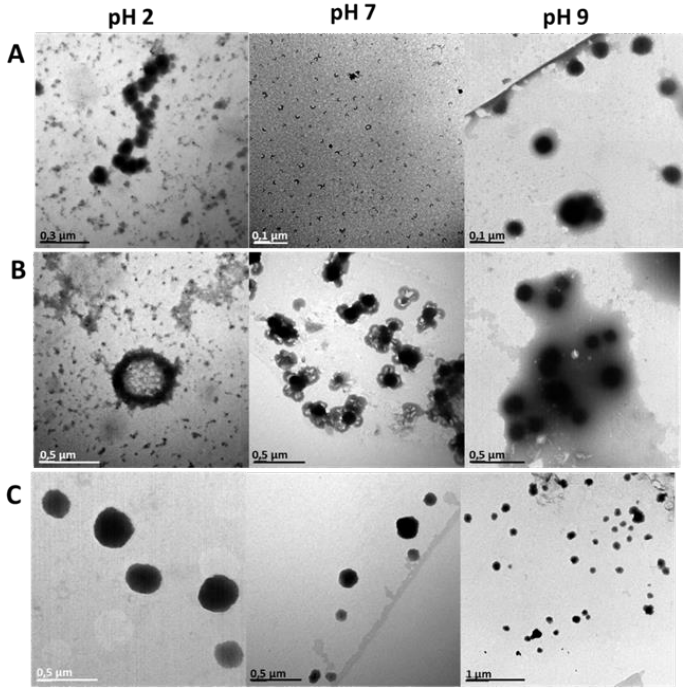
18.89 Measurements with the same superscript letter indicate no significant difference, according to Fisher’s test ( p < 0.05).